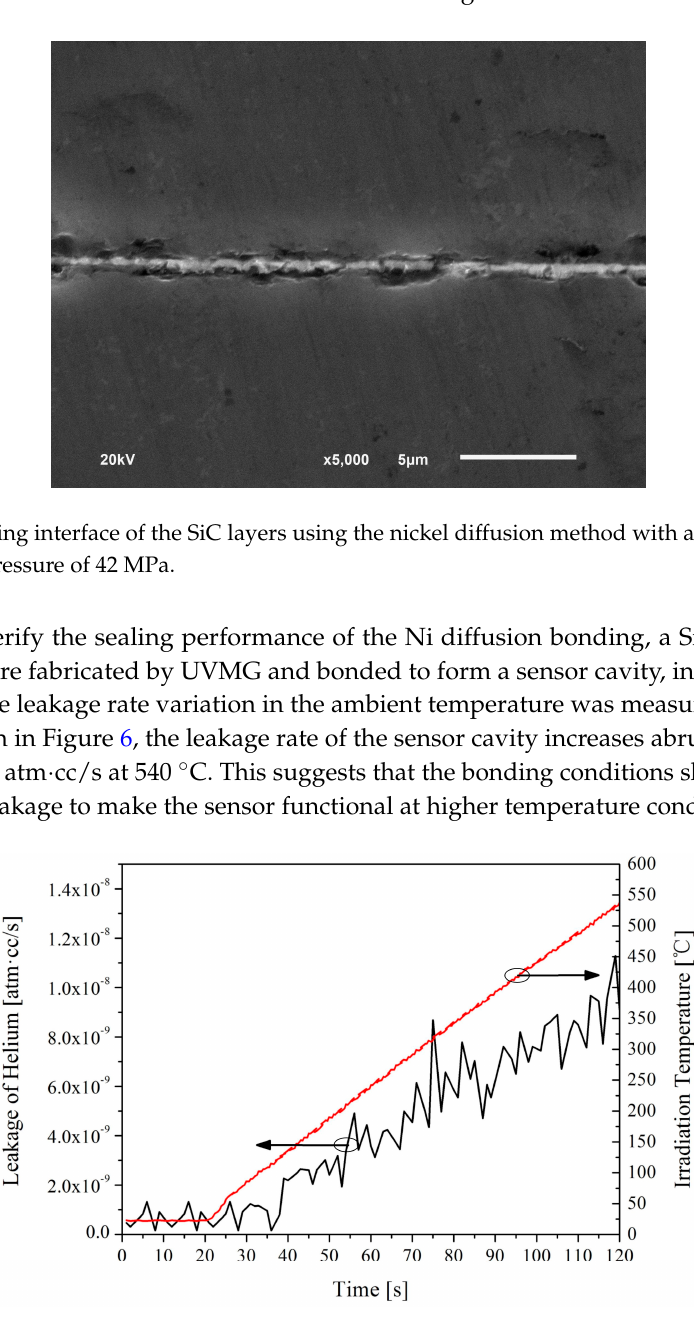
Figure 6. Leakage rate of the sensor cavity measured by helium detector variation with the ambient temperature.